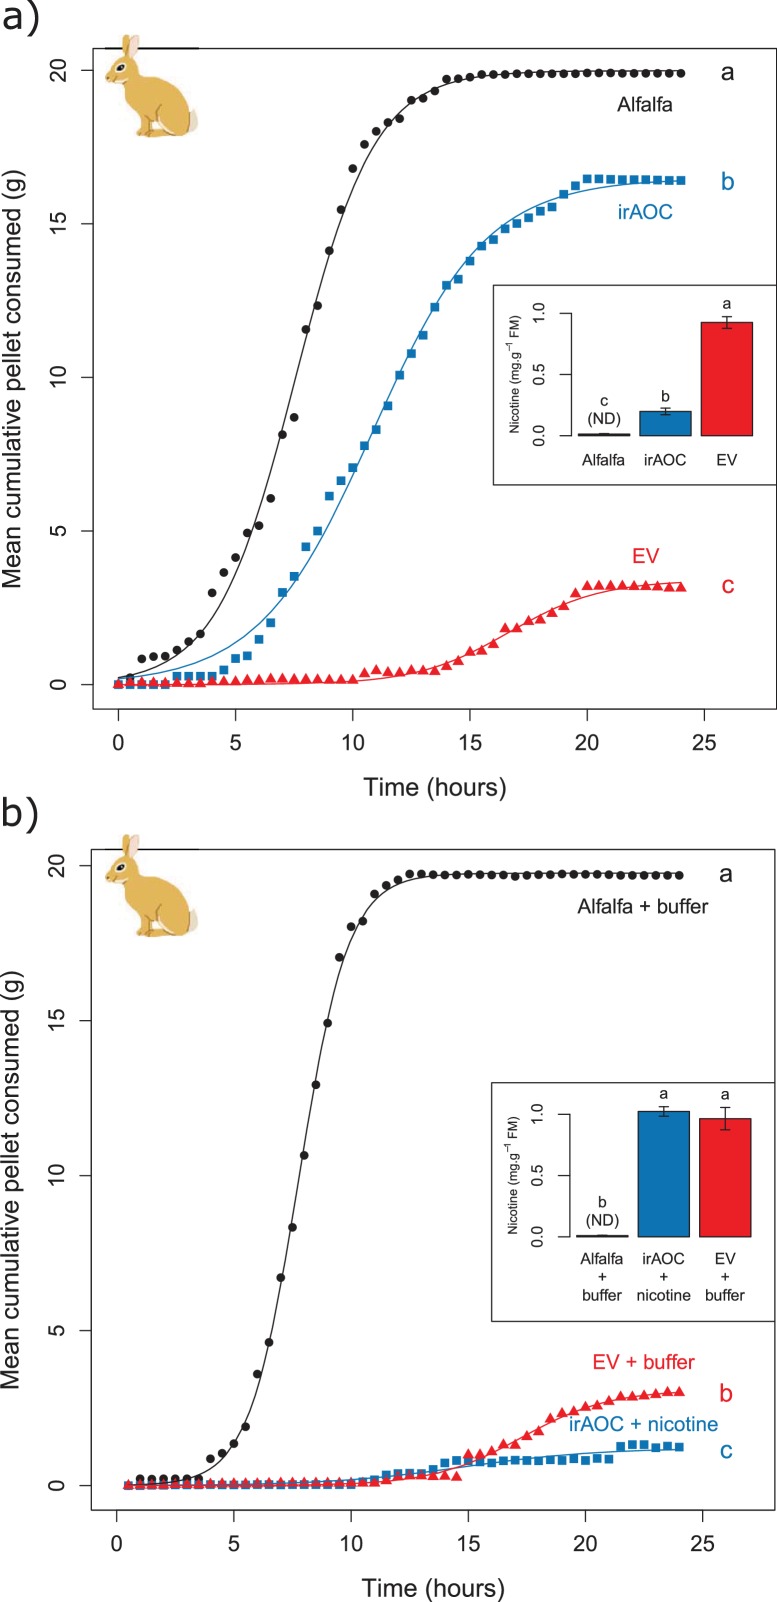
Jasmonate-dependent nicotine determines feeding preferences of a native vertebrate herbivore.Average amounts of food consumption by cottontail rabbits in a choice experiment. Choice experiments were carried out with EV, irAOC and alfalfa pellets (a) (n = 8) or with EV, irAOC+nicotine and alfalfa pellets (b) (n = 9). Letters indicate significant differences in curve asymptotes tested based on asymptote confidence intervals of logistic models (p<0.001). Insets: nicotine contents of the different pellets. Letters indicate significant differences (p<0.05). N.D: not detected.DOI:
http://dx.doi.org/10.7554/eLife.13720.01710.7554/eLife.13720.018Figure 4—source data 1.Impact of drying on secondary metabolite profiles.DOI:
http://dx.doi.org/10.7554/eLife.13720.01810.7554/eLife.13720.019Figure 4—source data 2.Nicotine concentrations in pellets.DOI:
http://dx.doi.org/10.7554/eLife.13720.01910.7554/eLife.13720.020Figure 4—source data 3.Results of choice experiment (repetition).DOI:
http://dx.doi.org/10.7554/eLife.13720.02010.7554/eLife.13720.021Figure 4—source data 4.Results of nicotine complementation experiment (repetition).